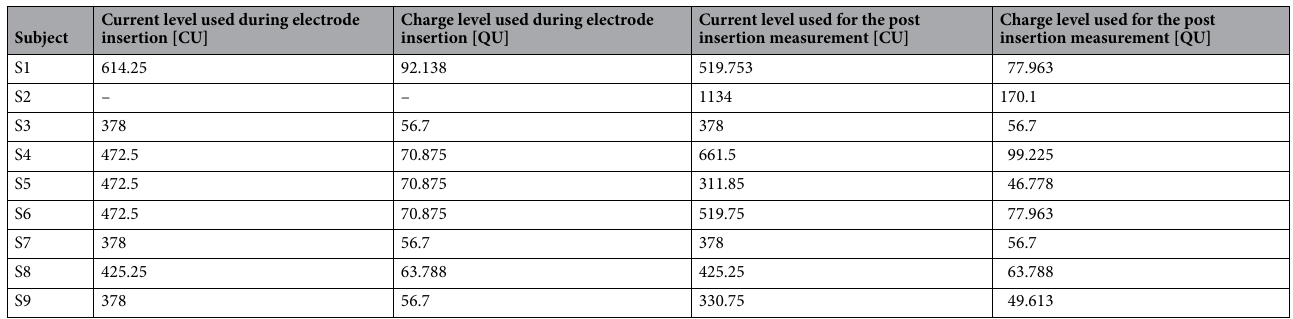
Table 3. Stimulation levels used for evoking EMG responses during both measurement procedures. Column 2 and 4 contain the current levels used for the real-time measurement and the post insertion measurement, respectively. Column 3 and 5 contain the corresponding charge levels for columns 2 and